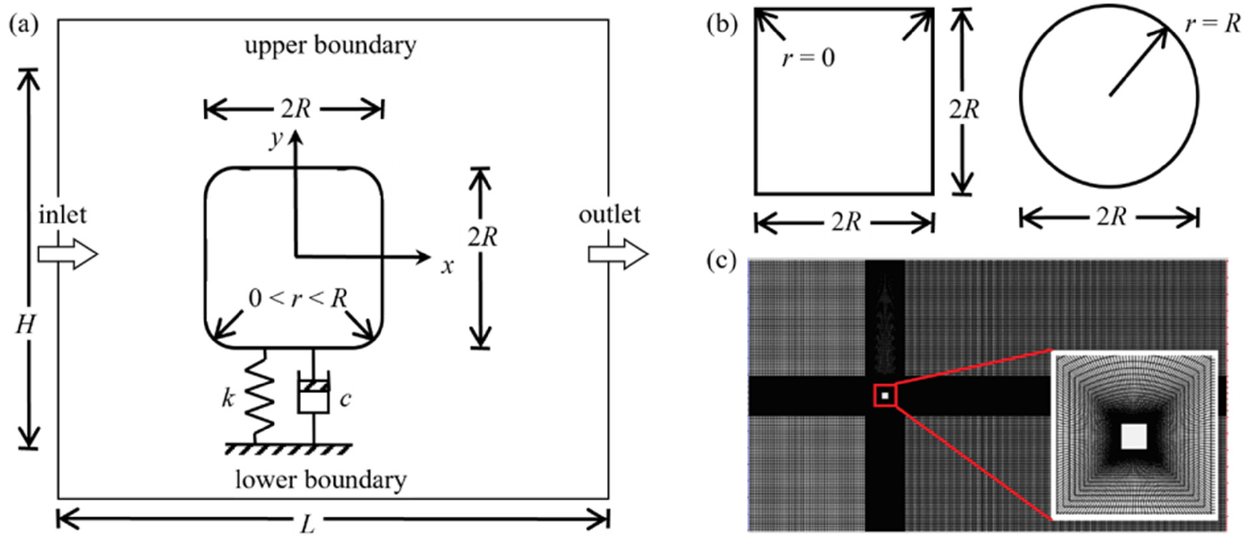
Figure 1. ( a ) Spring-damper model of an oscillating cylinder. ( b ) Changing corner radius ratio moving from square to the circular cylinder. ( c ) Computational domain with a fine grid structure and zoomed-in view of grids around the square cylinder .